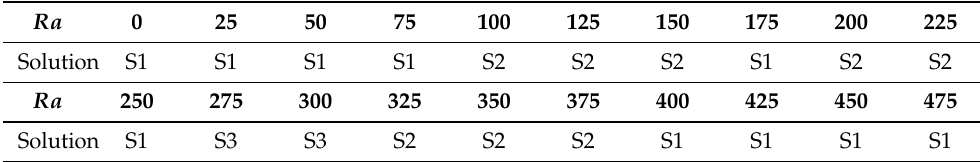
Table 4. Steady-state solutions obtained for different Ra on the grid l =